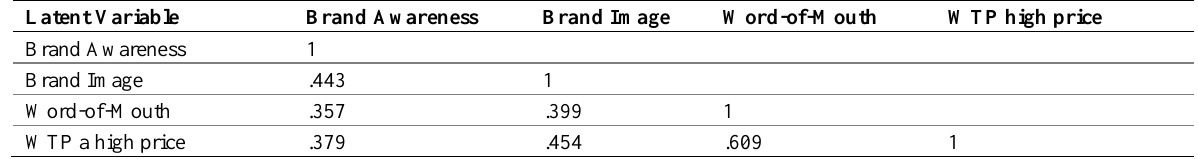
Table 4: Results of Heterotrait-Monotrait Ratio